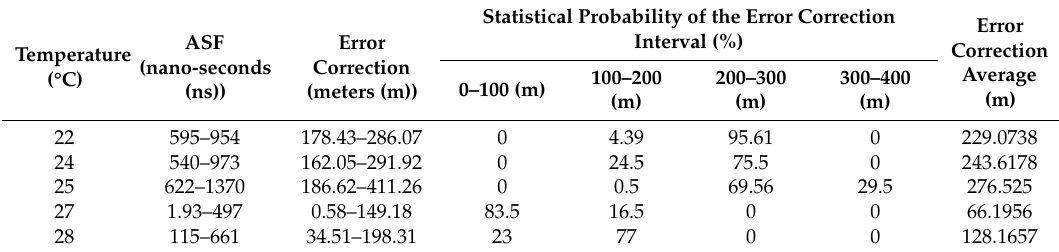
Table 1. The corresponding data change table of Figure 12.